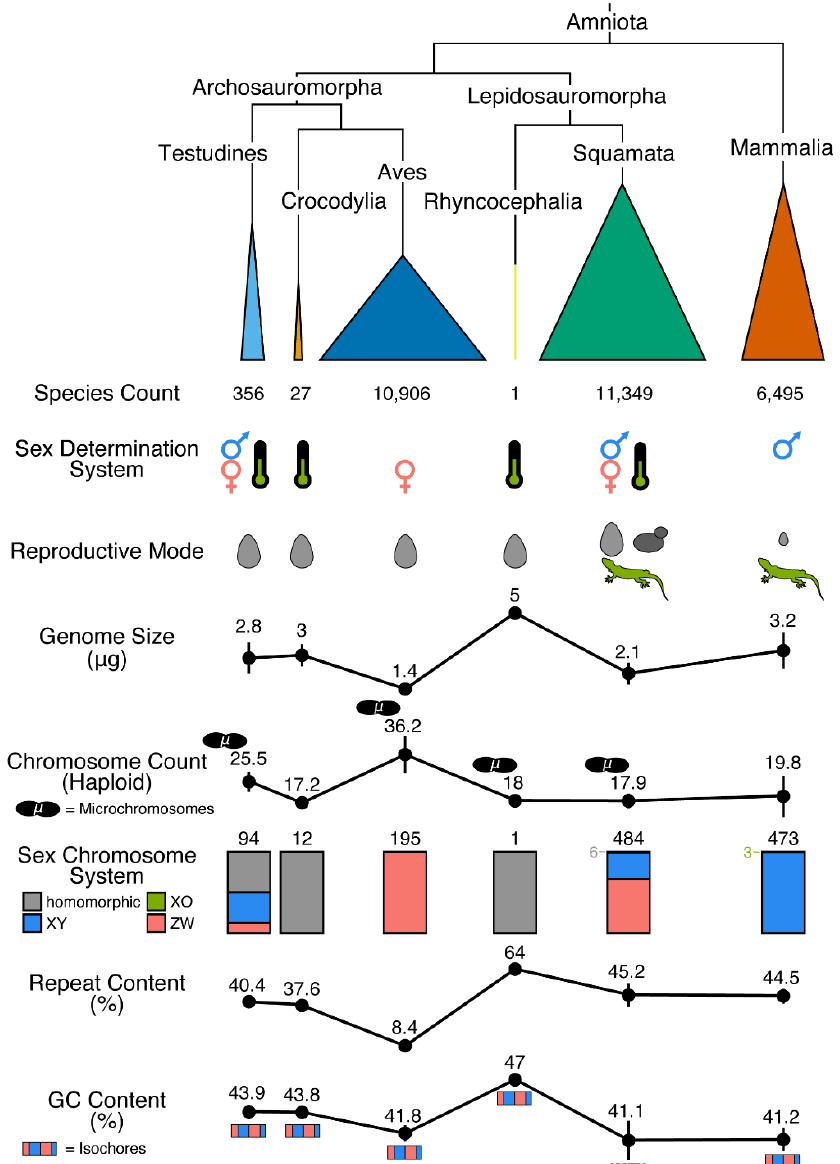
Figure 1. Overview of the natural history of amniotes, including non-avian reptiles, in a phylogenetic context. The width of clades on the phylogeny is proportional to species diversity, which are noted for each clade. For sex determination, GSD is denoted by the male and female symbols for male and female heterogamety, respectively, and TSD is denoted by the thermometer symbol [8,9]. Reproductive mode is indicated with an egg (oviparity), a lizard (viviparity), and a budding yeast symbol (parthenogenesis) [8,10 – 12]. Note the small egg for mammals that reflects the oviparous Monotremata (5 extant species). For genome size (C-value), data from the Animal Genome Size Database [13] were averaged per species and the clade-wise average was calculated as the mean of these species estimates. Karyotype is reported as the mean number of haploid chromosome counts per clade based on the ACC database (https://cromanpa94.github.io/ACC/ (accessed on 1 December 2022)) and lineages with microchromosomes present are indicated with a symbol near the mean chromosome count. Sex chromosome data were gathered from the Tree of Sex database [14]: the proportions of homomorphic, XY, XO, and ZW sex chromosome systems for each clade are indicated with the total species sample size per clade. The small number of squamates with homomorphic sex chromosomes (N = 6) and mammals with XO sex chromosomes (N = 3) are noted, and for counting purposes, complex XY and ZW systems were set to XY and ZW systems, respectively. For repeat content (reported as percentage of the total genome), data from the literature (see [15 – 21] and references therein) were averaged per clade. For GC content (reported as percentage of the total genome), data retrieved from the NCBI Genome Assembly database [22] were averaged per species